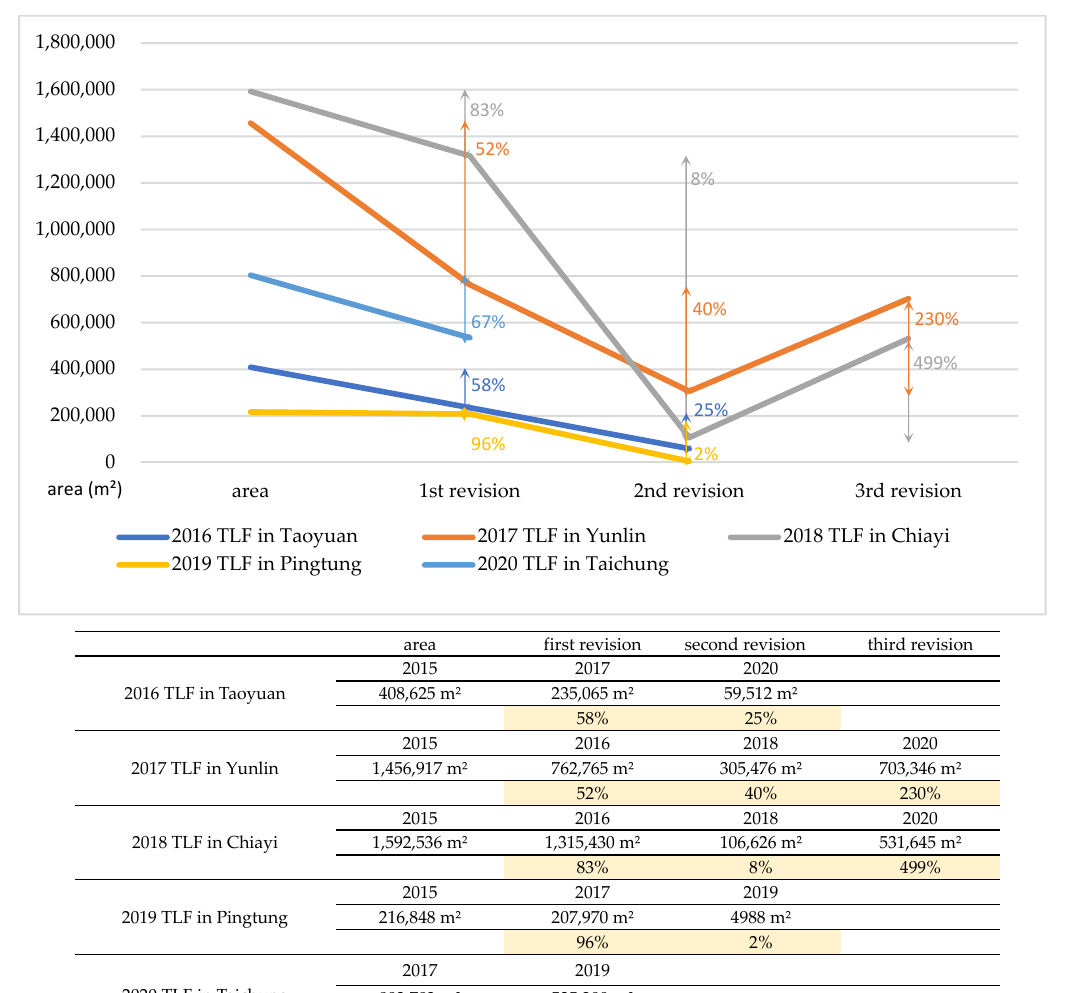
Figure 5. Yearly revision of the TLF site by specific land uses.